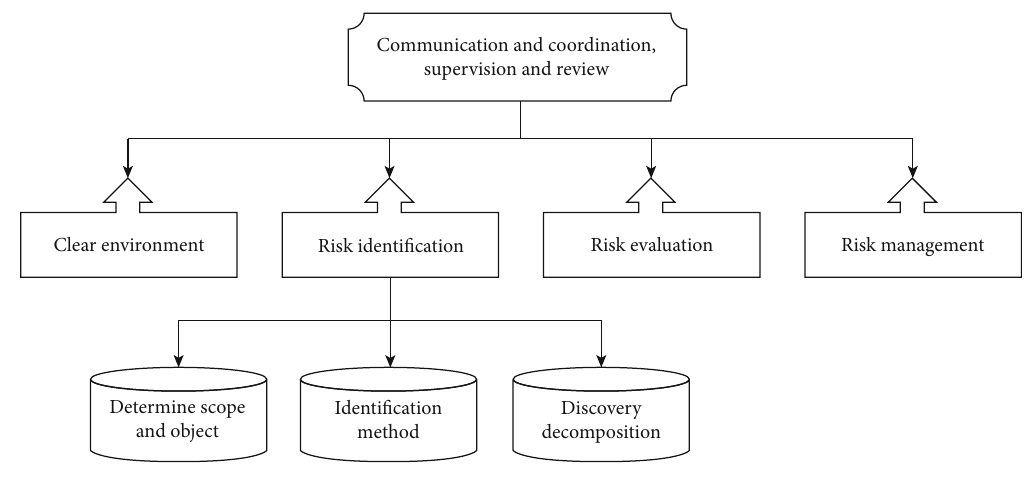
Figure 1: Risk management process.